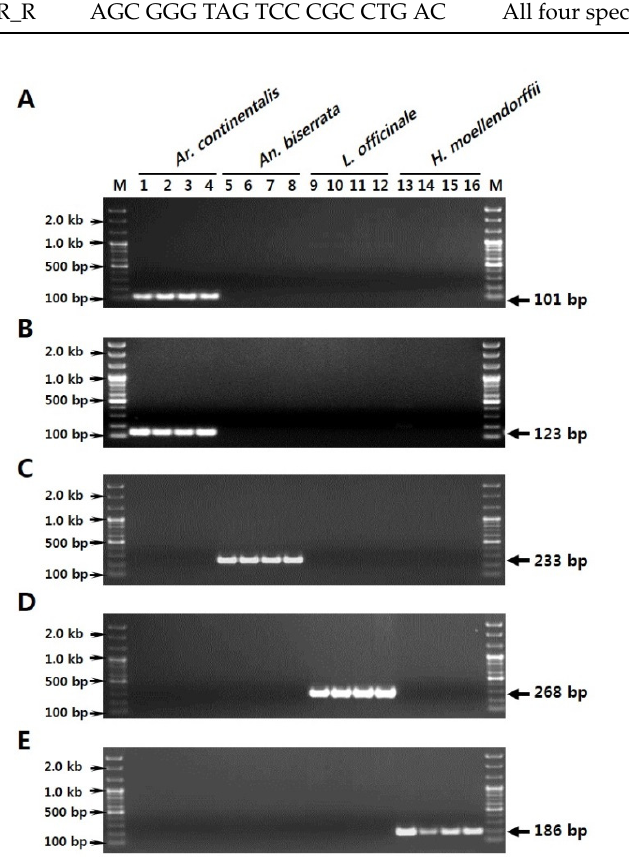
Figure 2. Development of species-specific SCAR markers from sequence variations in the ITS2